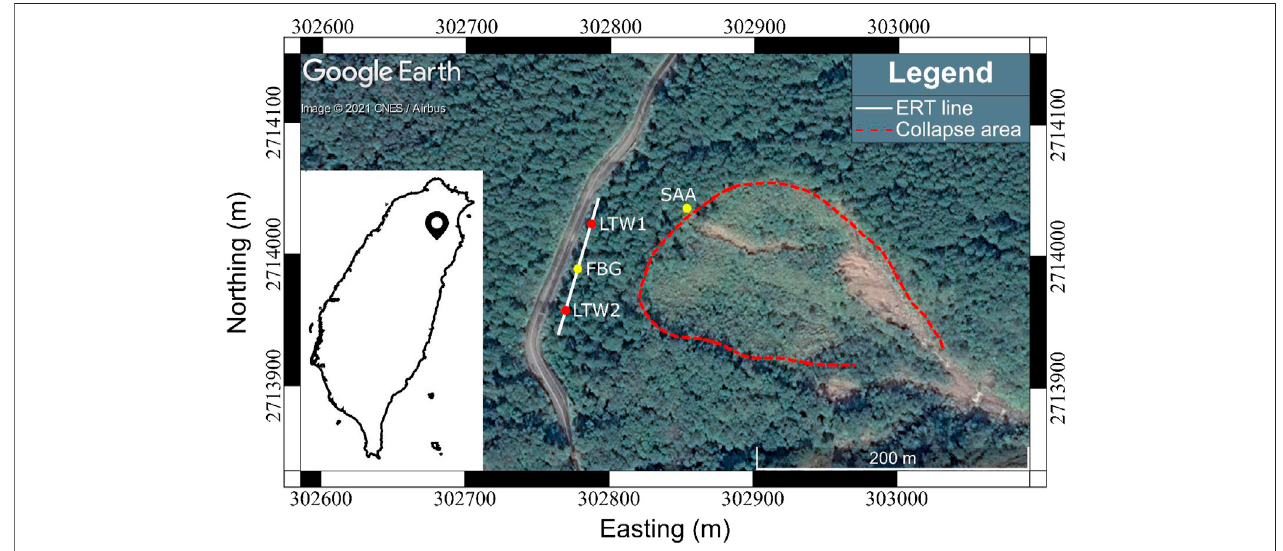
FIGURE1| Locationofthelandslidepotentialareaandlayoutofmonitoringboreholesinthestudyarea(modi fi edfromGoogleEarth).LTW1isthelocationofan84- m-deep borehole with ERT electrodes and LTW2 is the location of a 98-m-deep borehole with ERT electrodes and drilling core. SAA is the location of a borehole the shape acceleration arrayinstalled atthedepths between71.5and81.5 m;and FBGtheboreholefortheoptical fi ber Bragggratingpore pressuresensingarrayinstalled at the depths of 40, 50, and 60 m. A surface ERT line is also indicated by the white line joining through LTW1 and LTW2.